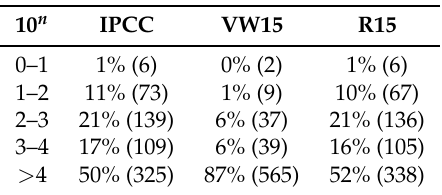
Table 1. Percentage (number) of tide gauge stations for every 10 n increase in the frequency of extreme events by 2100 per ice sheet scenario IPCC, VW15 and